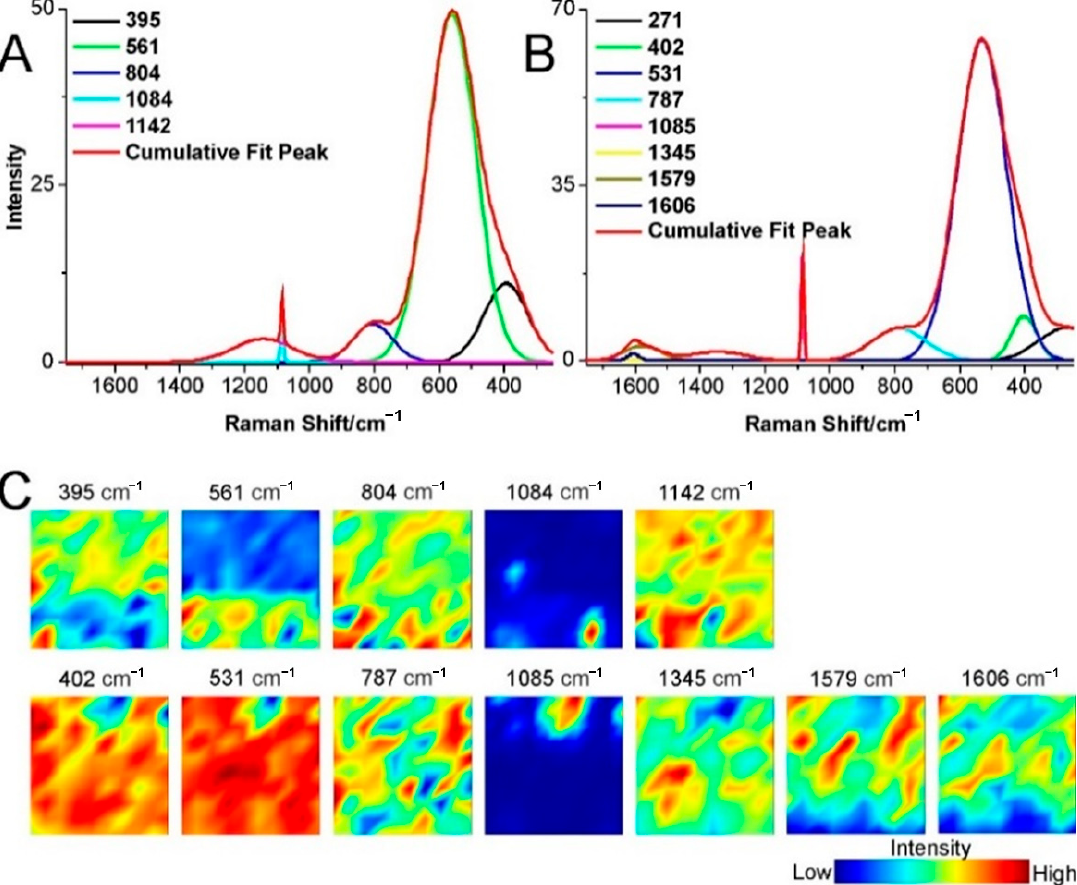
Figure 9. Deconvoluted Raman spectra of the WP4 ( A ) before and ( B ) after the reaction. ( C ) Raman maps with the distribution of selected WP4 bands (top row) before and (bottom row) after the reaction. Red spectra correspond to the cumulative spectrum consisting of the deconvoluted bands. Other colors of spectra correspond to the single deconvoluted bands.